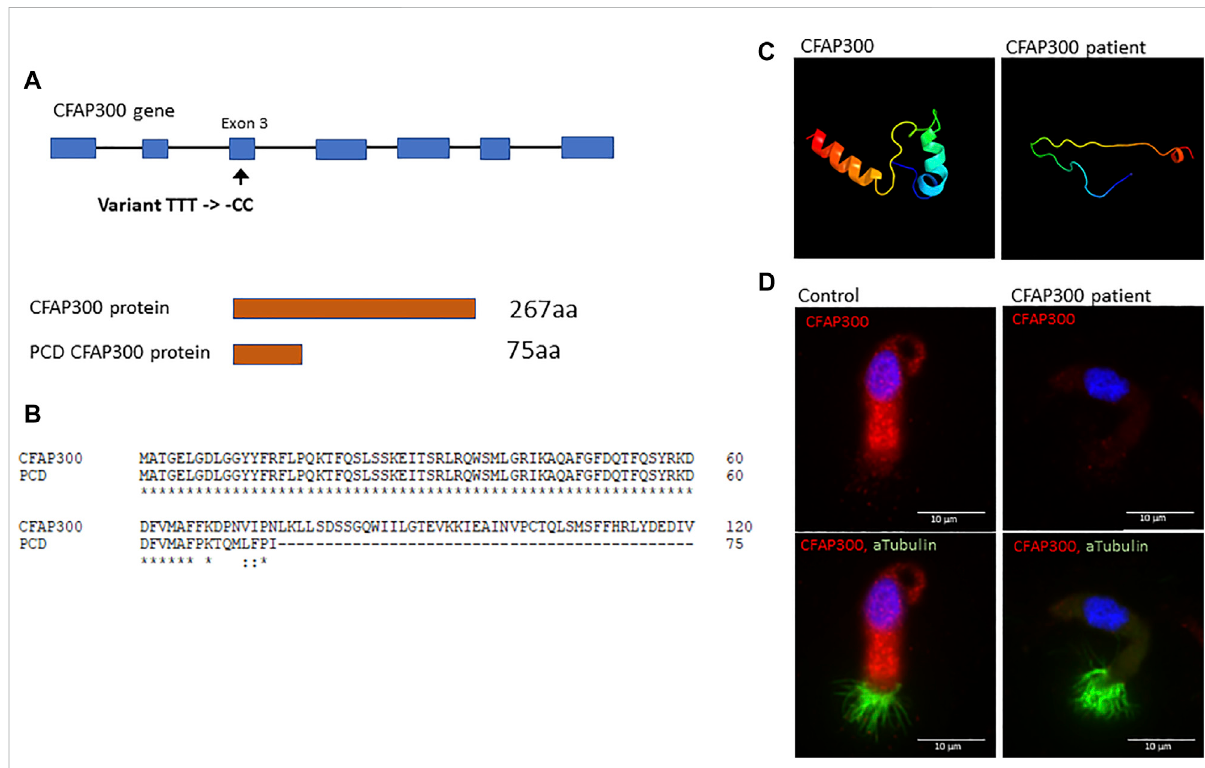
FIGURE 2 The effectofthe CFAP300 variant onproteinfunction. (A) .The CFAP300 variant (C) .198_200delinsCC results inpremature stop codonat76aa and protein product. (B) . Clustal Omega alignment of the control and PCD patient CFAP300 protein sequence. (C) . Structural changes in the CFAP300 proteinfolding basedonPhyre2. (D) .Cytoplasmiclocalization oftheCFAP300proteinproductappearsmissinginthePCDpatient (patient II-1). α Tubulin was used as a marker for cilia and Dapi as a nuclear stain. Scale bar is 10